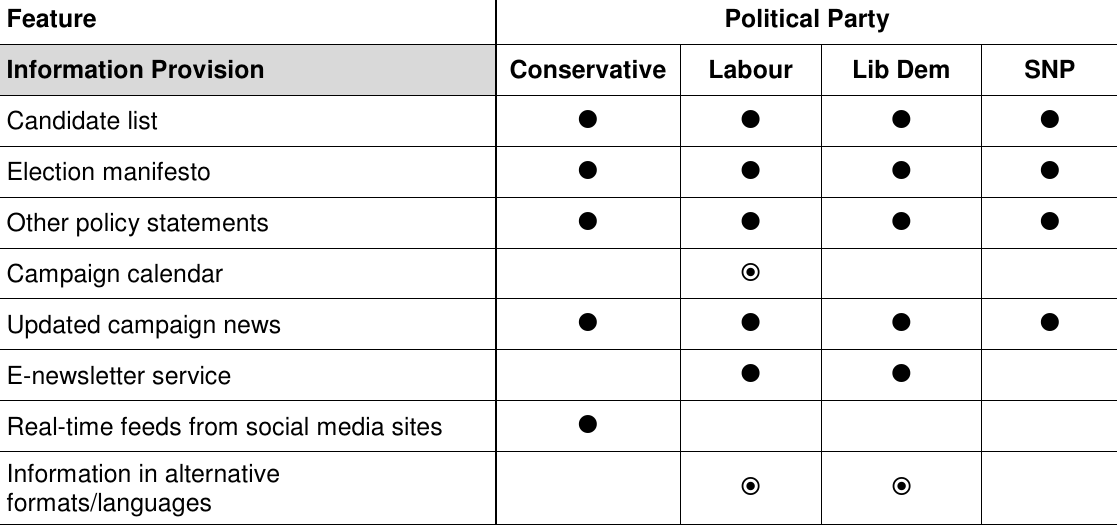
Table 1: Section of Party Website Content Analysis from 2010 UK General Election